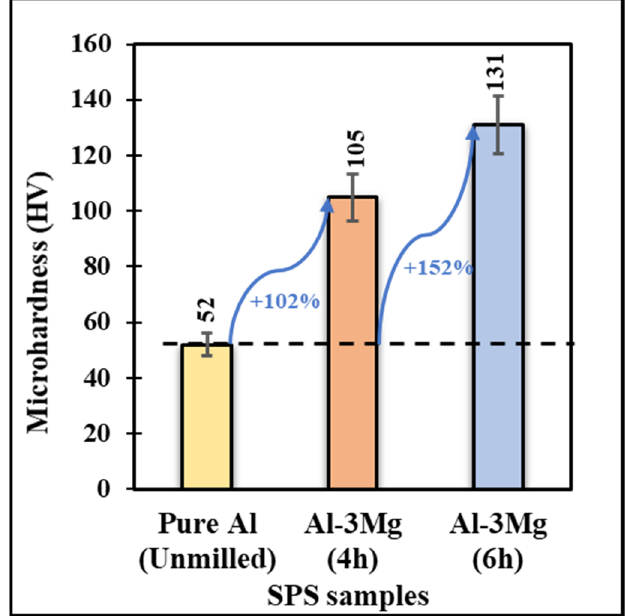
Figure 11. Vickers microhardness comparison for Al-3% Mg samples cryomilled for 4 h and 6 h with the pure Al SPS samples.